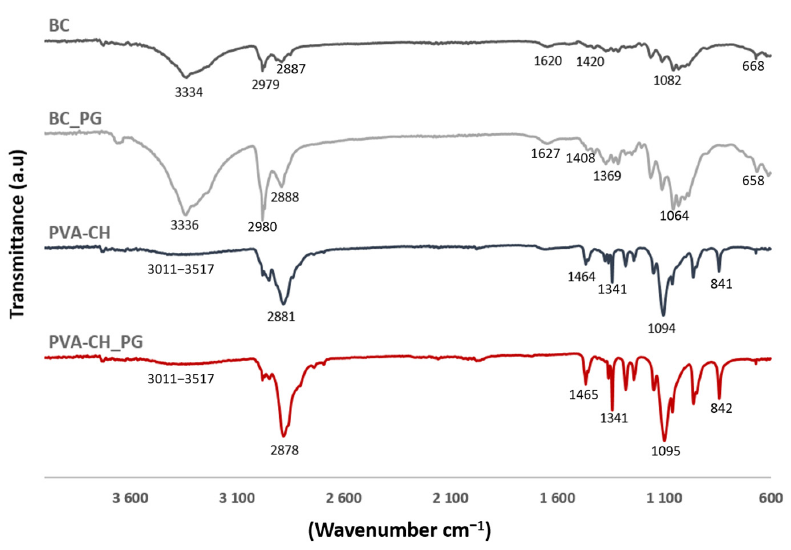
Figure 3. FTIR spectra of each composite layer, with (BC_PG and PVA-CH_PG) and without pig- ment incorporation (BC and